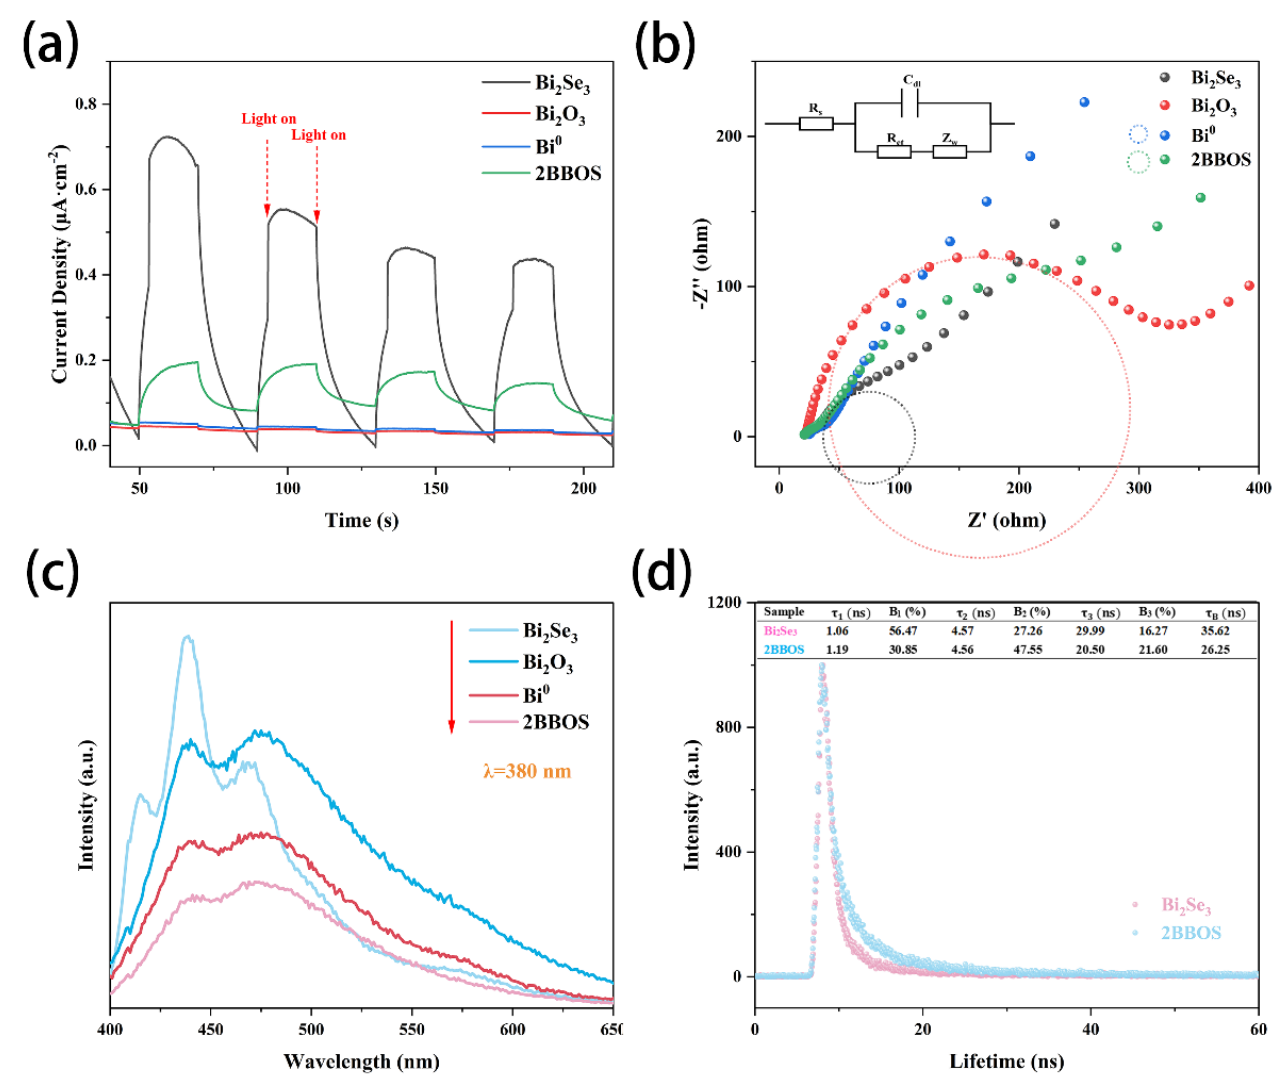
Figure 10. ( a ) Photocurrent responses (i-t) and ( b ) electrochemical impedance spectroscopy (EIS) curves of Bi 2 Se 3 , Bi 2 O 3 , Bi 0 and 2BBOS. ( c ) PL and ( d ) TR-PL spectra of samples.